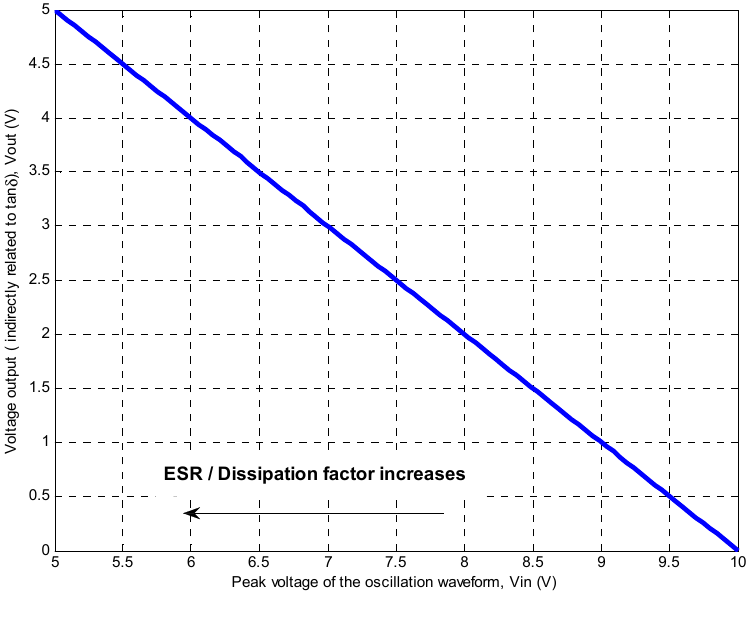
Figure 11. Output voltage proportional to tan δ depending on the peak voltage of the oscillation